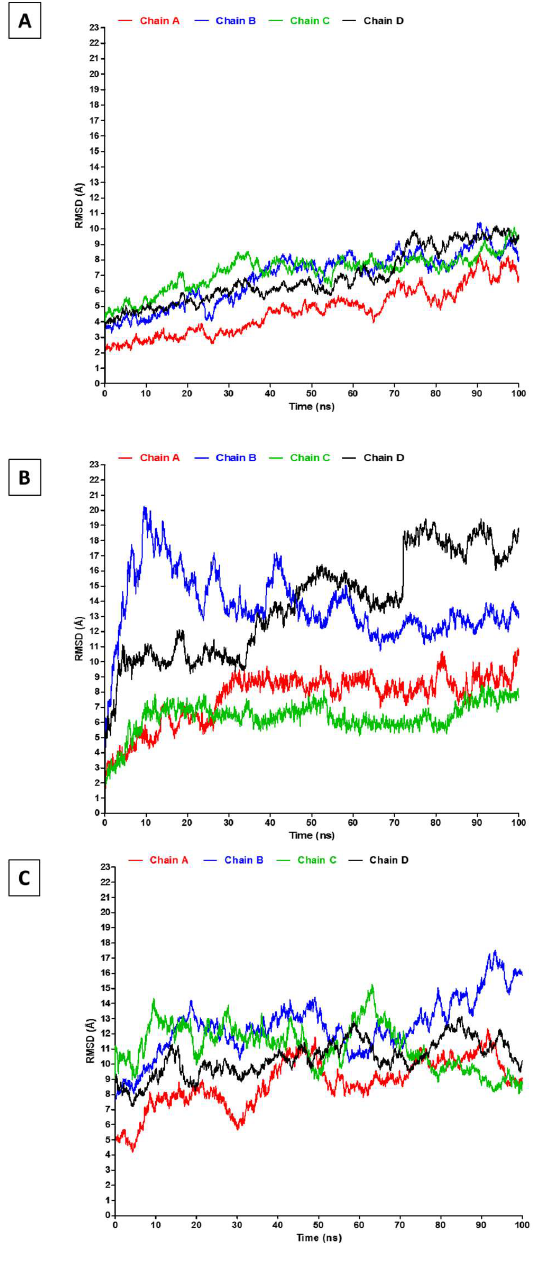
Figure 4. RMSD analysis of the four antibody chains. The RMSD of the two heavy chains (B and D) and light chains (A and C) for A : explicit; B : implicit; and C : explicit_ions simulations.